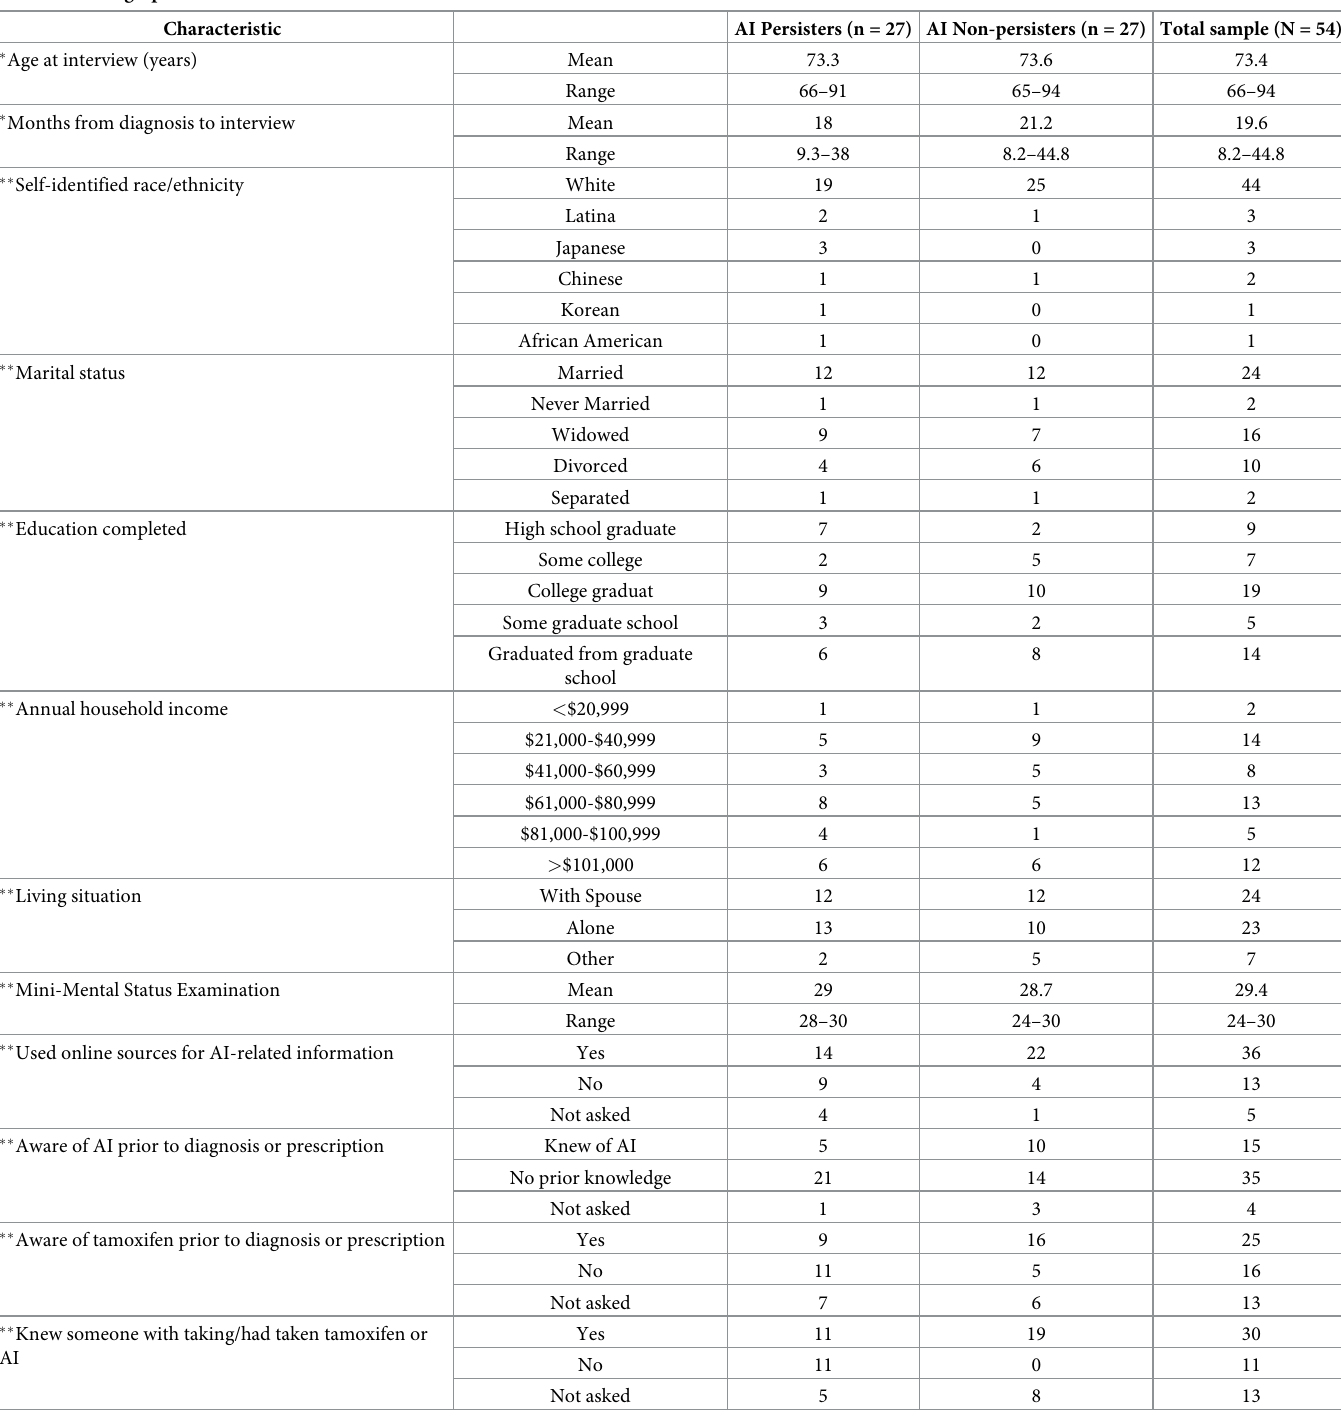
Table 2. Demographic characteristics.